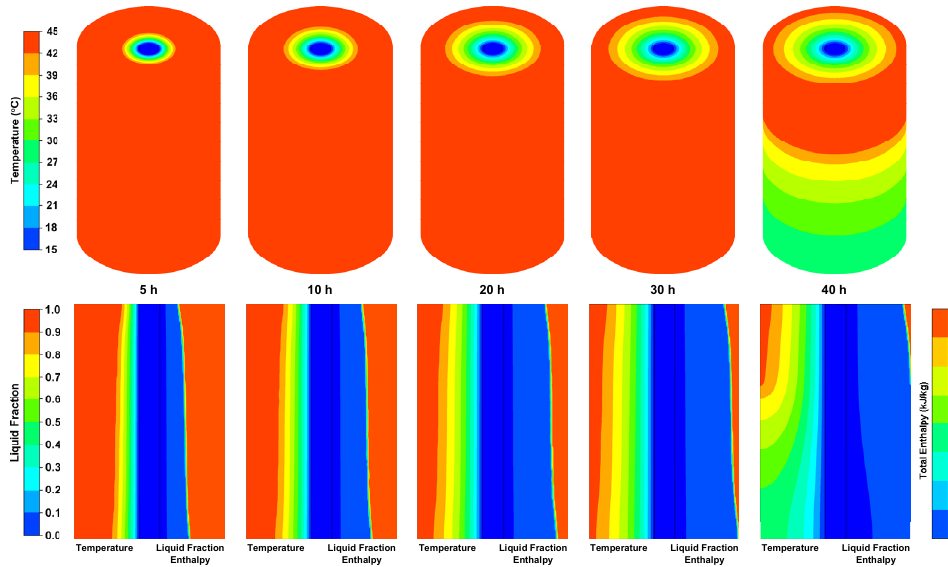
Figure 2. Temperature, total enthalpy and liquid fraction behaviour of paraffin while discharging in the shell-and-tube with no-fins (case 1).